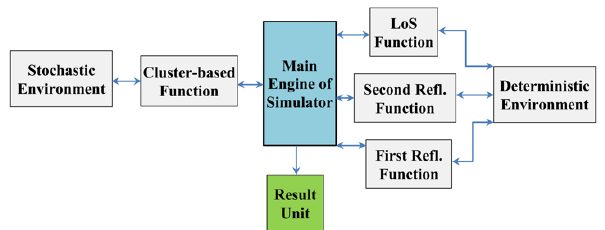
Figure 6. The structure of the simulator and sub-functions. An overview of the simulated indoor environment is shown in Fig. 7. The length, width and height of the Hall are 20.1 m, 20.2 m and 4.5 m, respectively. The platform is 0.8 m above the ground of the Hall, where Tx array antenna elements are placed 1.7 m above the center of the platform. Rx antenna is located in the mid of the hall at a distance of 4 m far from the center of the Tx antenna array. The height of Rx antenna is 2.0 m above the ground of the hall.